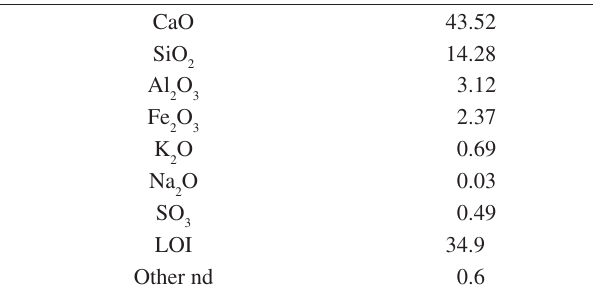
Table 2. Chemical analysis of the tire ashes (%